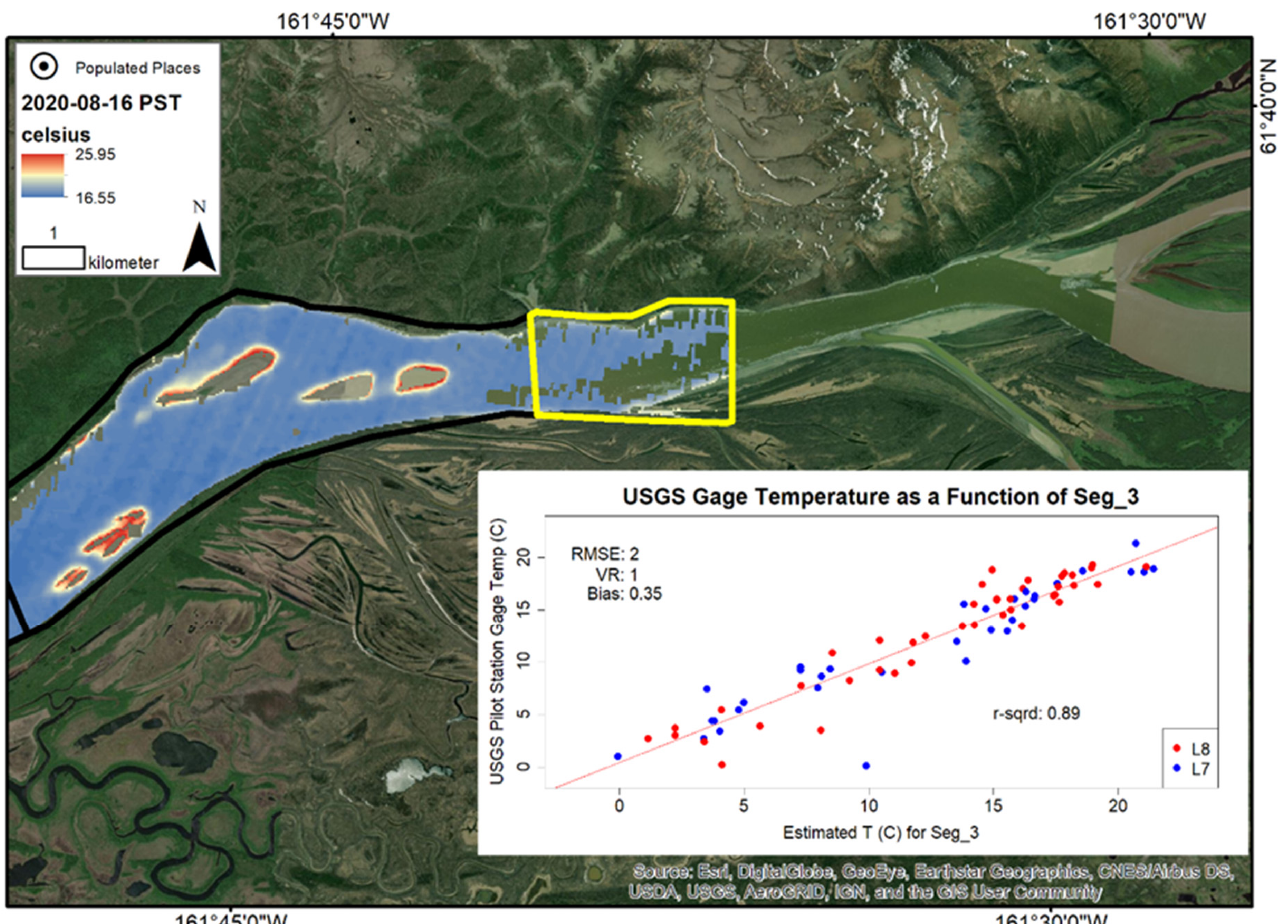
Figure A1. Segment 3 is the most upstream segment in the analysis and the single river segment with a river length of 3 km. Within this segment the Yukon River occupies a single channel with rolling uplands of the Ilivit Mountains to the north and vegetated floodplains to the south. Nearly half the river channel is covered by a permanent NoData gap. These NoData gaps are permanent gaps in the ARD dataset due to missing data within the Advanced Spaceborne Thermal Emission and Reflection Radiometer (ASTER) Global Emissivity Database (GED), i.e., an auxiliary input used in the derivation of pST [26]. Agreement between estimated water temperature within this segment and corresponding temperature records at Pilot Station was good (RMSE = 2 ◦ C, r 2 = 0.89) despite a 100 river mile separation. At average flow speeds of 8–13 km/h, water passing through this segment is 12–8 h upstream from the Pilot Station gaging